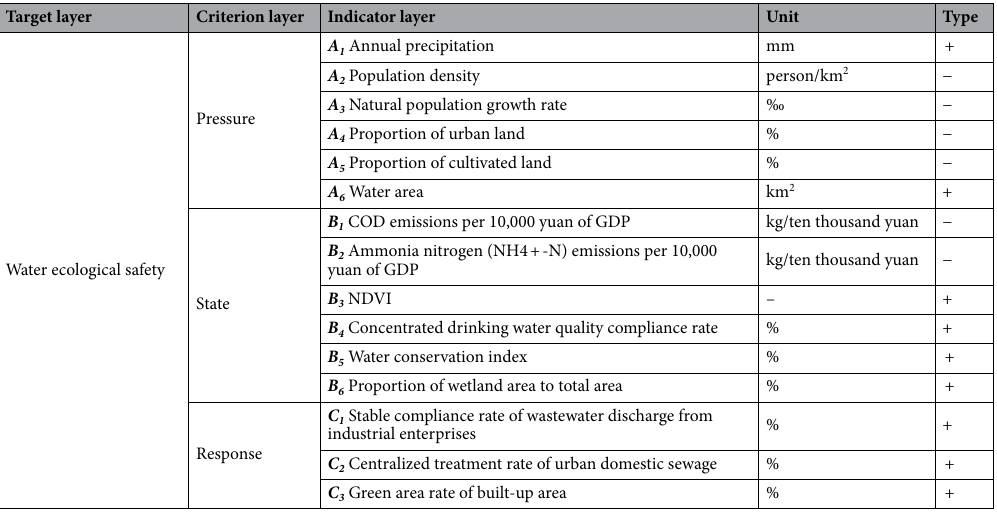
Table 1. Water ecological security evaluation index